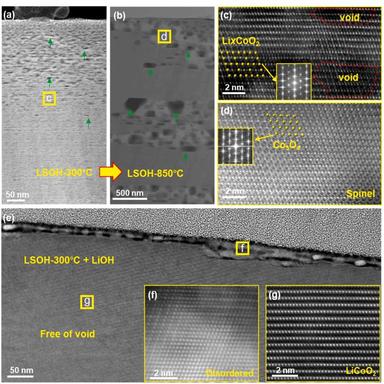
Lithium deficiency causing voids and spinel phase. (a) STEM-HAADF image showing the numerous voids in the LSOH sample after 300 ◦C heating (without lithium replenishment).(b) STEM-HAADF image showing the voids grow into much larger size after 850 ◦C heating (without lithium replenishment). Void defects are highlighted by the green arrows. (c, d) Enlarged lattice images showing the two yellow frames "c" and "d" in (a) and (b), respectively. The spinel structure feature is identified in (c, d). (e) STEM-HAADF